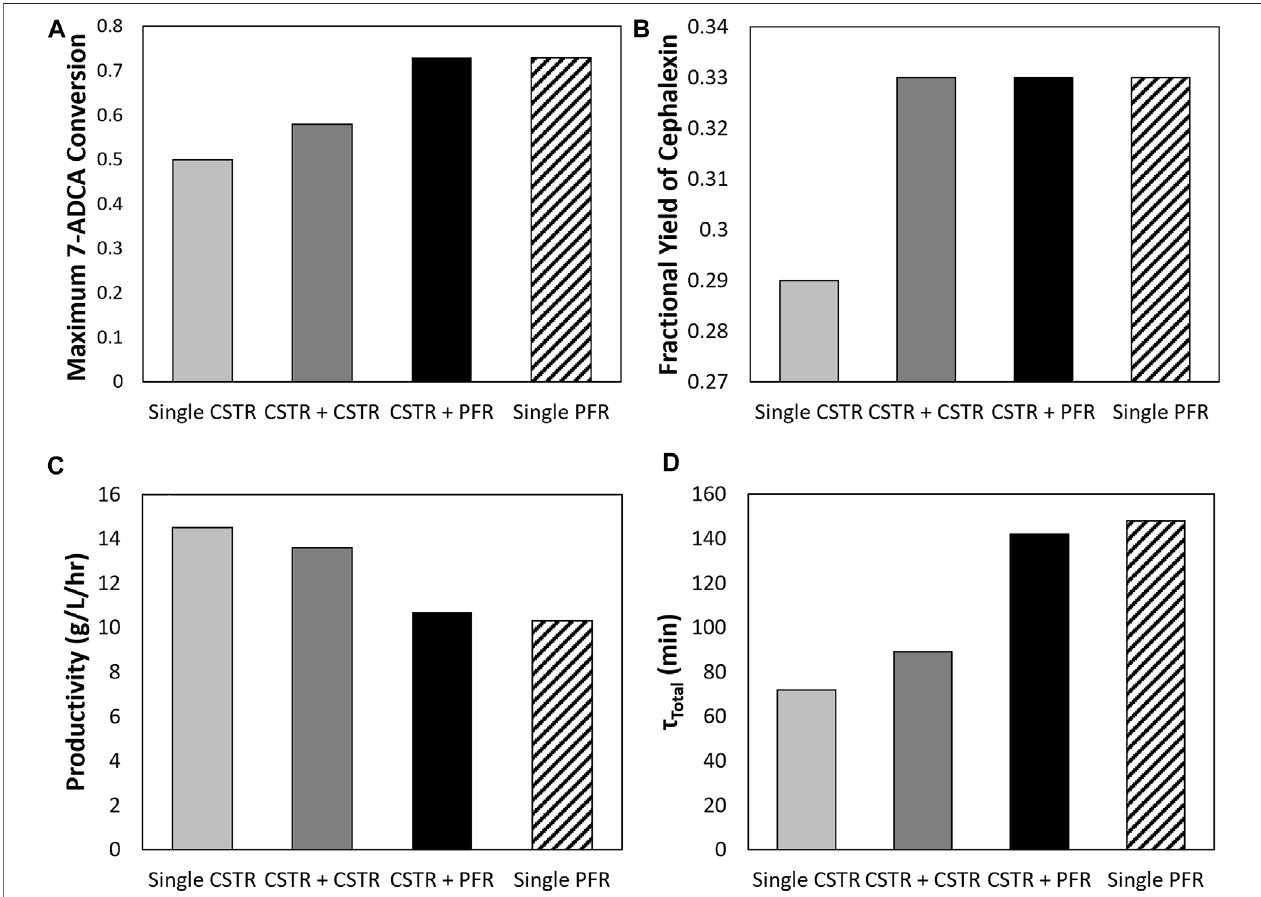
FIGURE7| Acomparisonisshownofthe (A) maximum7-ADCAconversionaswellasthe (B) fractionalyieldatthemaximum7-ADCAconversion, (C) productivity at maximum 7-ADCA conversion, and (D) total residence time at maximum 7-ADCA conversion for an inlet reactor concentration of 250 mM PGME and 100 mM 7- ADCA and AEH concentration of 200 nM is shown for the single CSTR, single PFR, CSTR plus CSTR, and CSTR plus PFR systems.